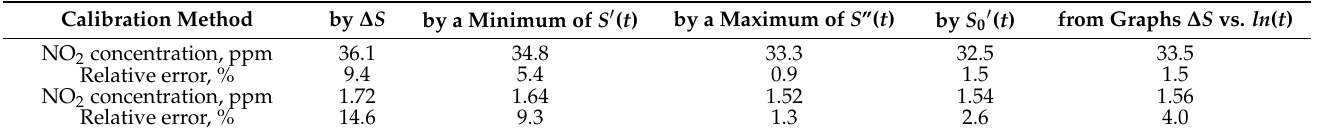
Figure 10. Calibration curve plotted from graphs ∆ S vs. ln ( t ): ( a ) Type 1 sensor; ( b ) Type 2 sensor. Table 1. The results of an experiment to verify the error in estimating the gas concentration using various calibration